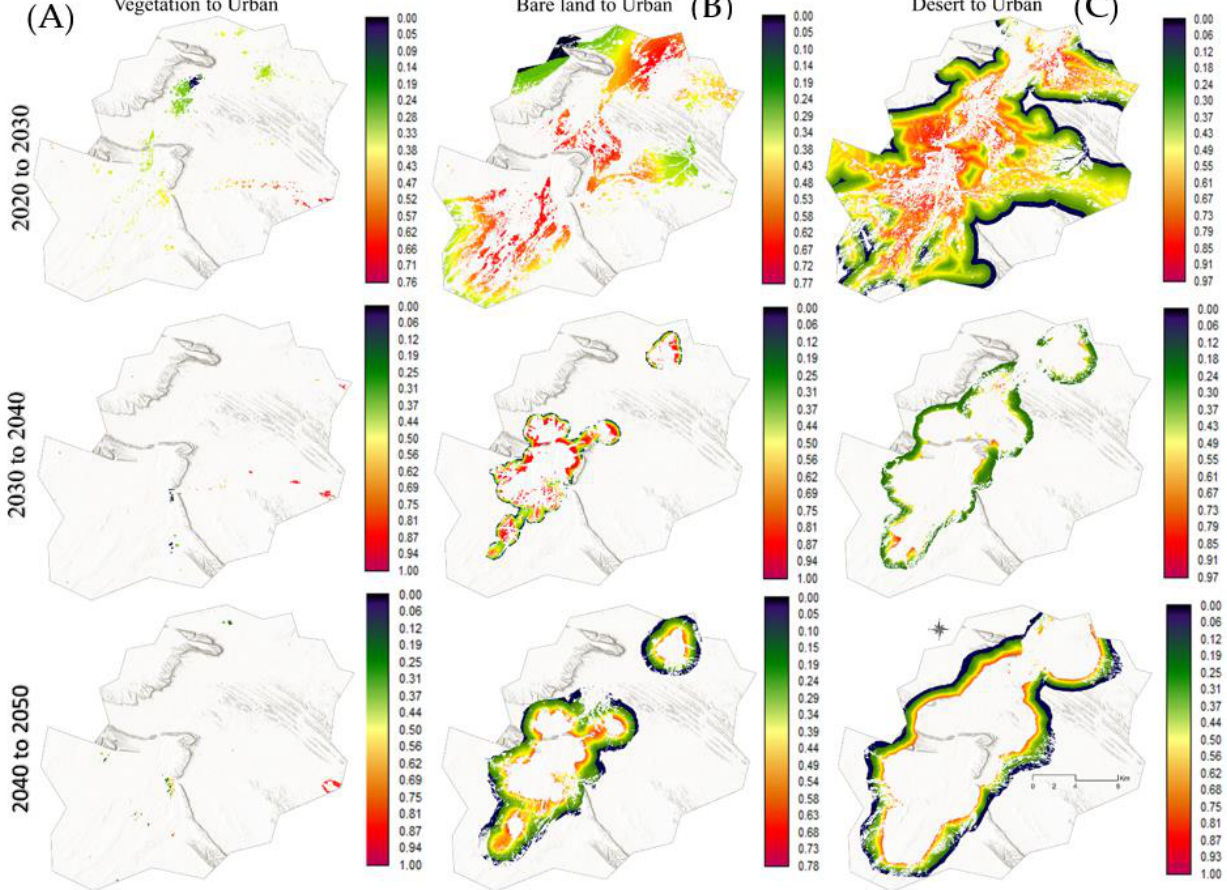
Figure 5. Potential areas for transition into urban land and the probability of being built-up (2030 to 2050): vegetation to urban ( A ), bare land to urban ( B ), and desert to urban ( C ).